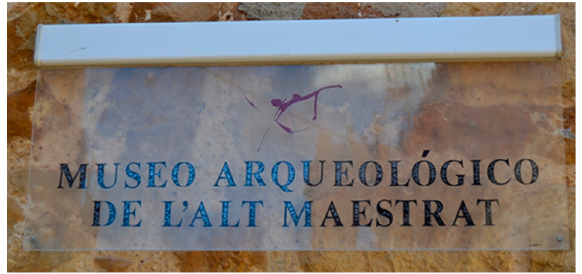
Figure 40. Benasal: Language contact on a museum sign .